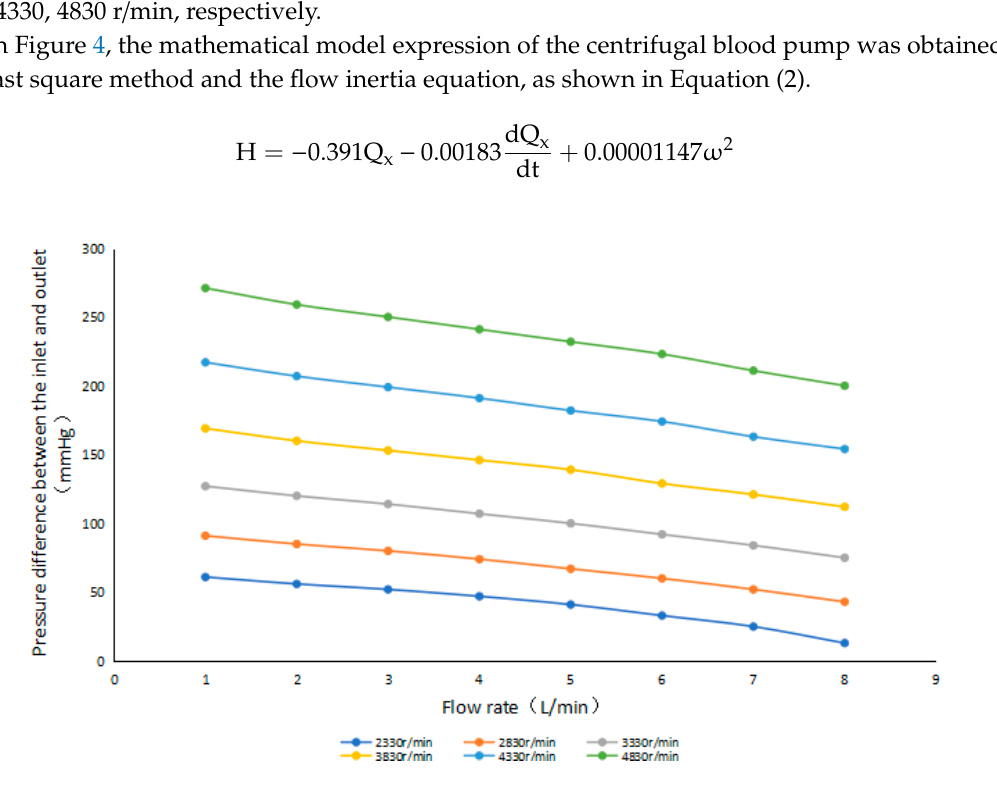
Figure 4. Pressure difference-flow characteristic curve of the centrifugal blood pump.